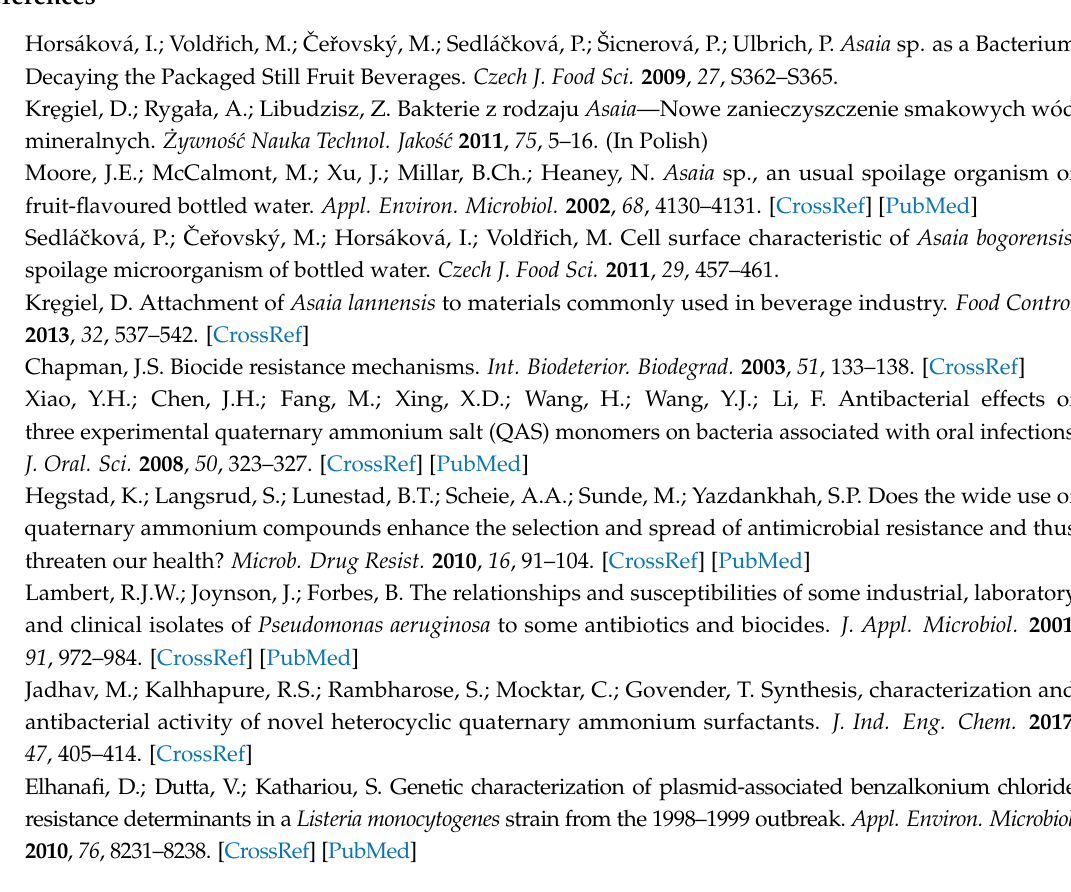
Supplementary Materials: Supplementary materials are available online. Table S1: The inhibition of Asaia lannensis cells forming biofilms [%] in the presence of monomeric (DTAB) or gemini (C6) surfactants. Author Contributions: A.K. conceived and designed the experiments; performed the experiments; A.K., D.K. and B.B. analyzed the data; B.B. contributed reagents tools; A.K., D.K. and B.B. wrote the paper. Conflicts of Interest: The authors declare no conflict of